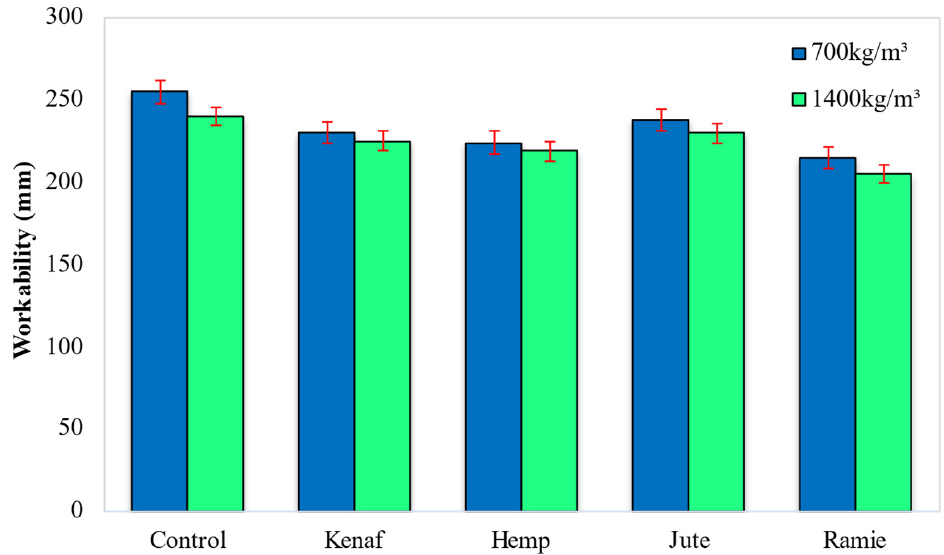
Figure 7. Influence of different types of fiber on the workability of fresh LFC